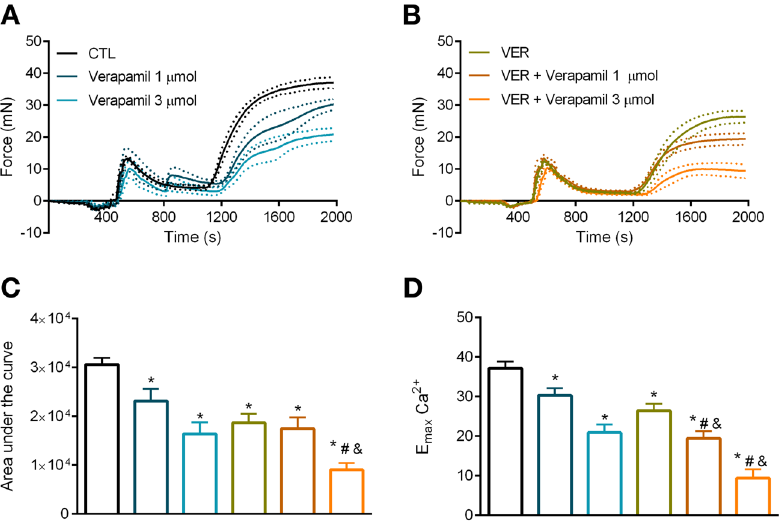
2 + Figure 4. Blockade of HSP70 enhances the inhibitory effect of an L-type Ca channel blocker in aorta 2 + stimulated with phenylephrine. Aortic rings were challenged with phenylephrine ( 10 µ mol/l ) in 0[ Ca ] Krebs’ solution in the presence of vehicle (CTL) or ( A ) verapamil (1 and 3 µ mol/l, DMSO diluted) or ( B ) VER155008 ( 10 µ mol/l , DMSO diluted) as well as the combination of verapamil and VER155008. Inhibitors were added 2 + 2 + after IP3r-mediated Ca release. The concentration of Ca was restored after 10 min, and the force developed was evaluated for 15 min. ( C ) Area under the curve and ( D ) E max . Panels ( C , D ) use the same color scheme as panels ( A , B ). Data are expressed as mean ± SEM. n = 9 for CTL and VER and n = 5 for all other groups, * p < 0.05 vs. CTL, # p < 0.05 vs. verapamil, and& p < 0.05 vs. VER.